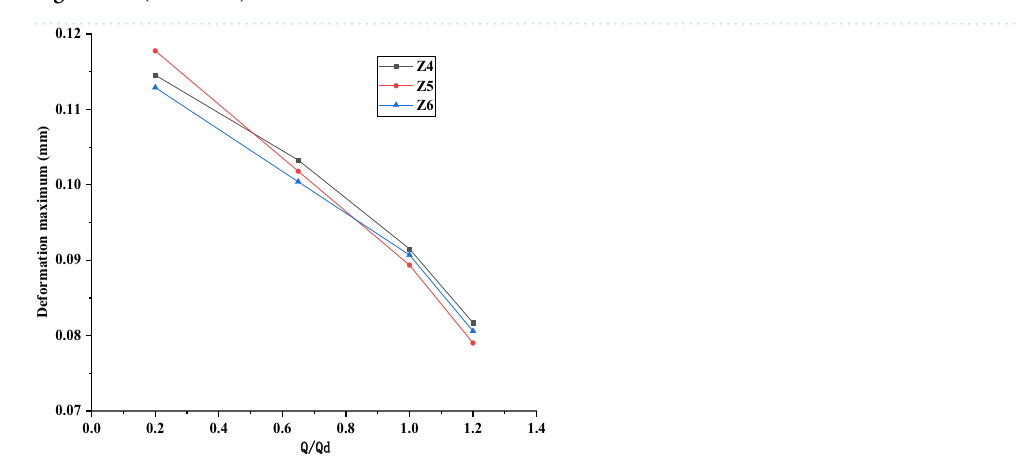
Figure 13. Variation of the maximum deformation of three models under four working